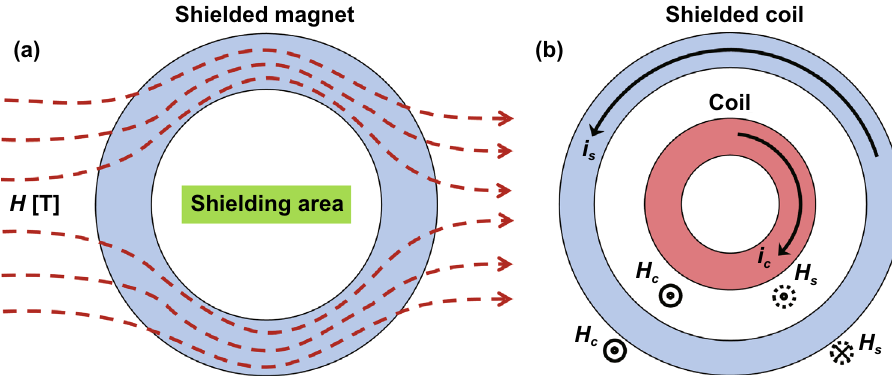
Fig. 2 Schematic diagram of EMI shielding mechanism of a low-frequency magnetic field and b high-frequency magnetic